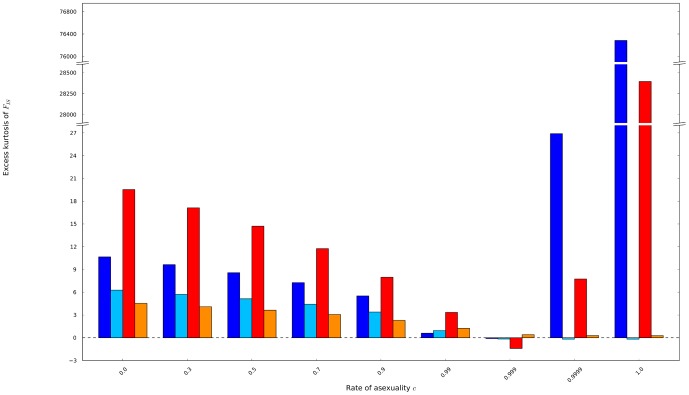
the kurtosis excesses of the possible distributions of F
IS were obtained from populations of 60 individuals mutating at a rate of 10−8 (dark blue) and 10−3 (light blue), and from populations of 140 individuals mutating at a rate of 10−8 (red) and 10−3 (orange).